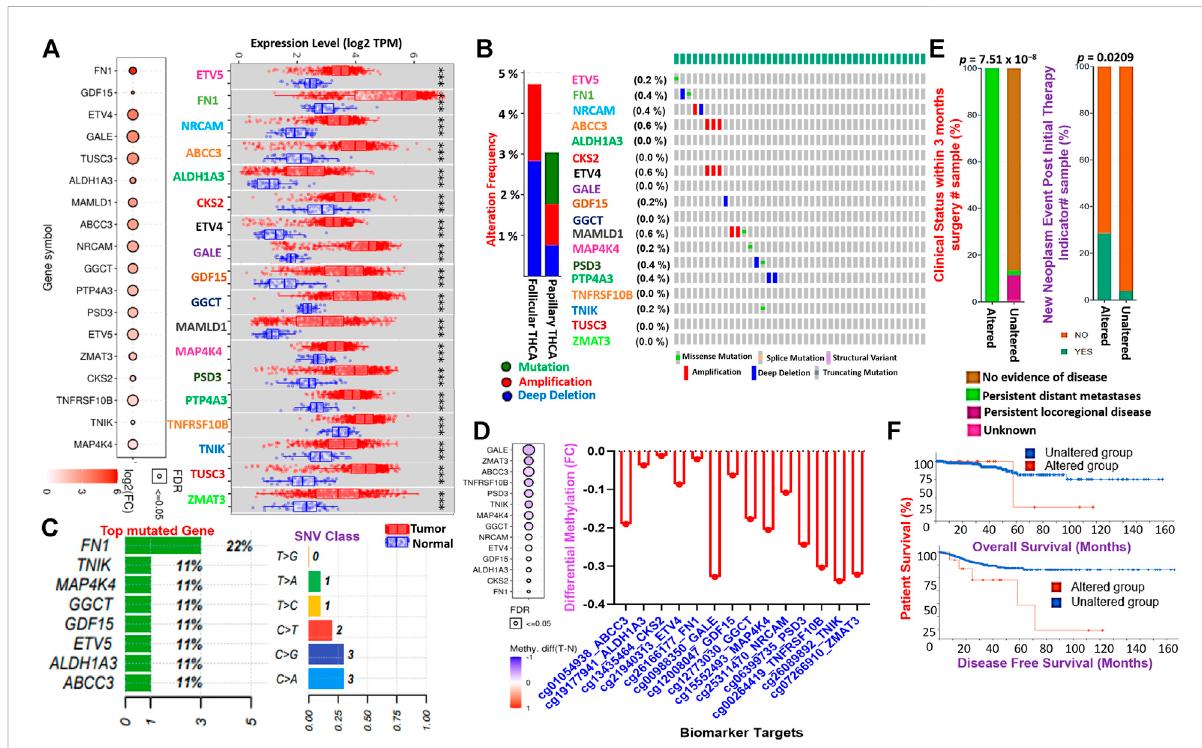
FIGURE 3 TTEPs are associated with poor surgical outcome, distant metastasis, and poor prognosis in THCA cohorts. (A) Bubble and boxplots of the mRNAexpressionlevelsoftheTTEPsbetweenTCGAthyroidtumorandadjacentnormaltissues. (B) Barandwaterfallofthegeneticalterationpro fi le and (C) mutation plots of the TTEPsin TCGA pan-cancer of THCA cohorts. (D) Bubble and bar plots of the methylation status of the TTEPs in TCGA- THCA cohorts. (E) Bars plot of the clinical attribute of TCGA-THCA cohorts with genetically alteredTTEPs. (F) Kaplan – Meier plots of the overall and disease-free survival differences between TCGA-THCA cohorts with genetically altered and wild-type